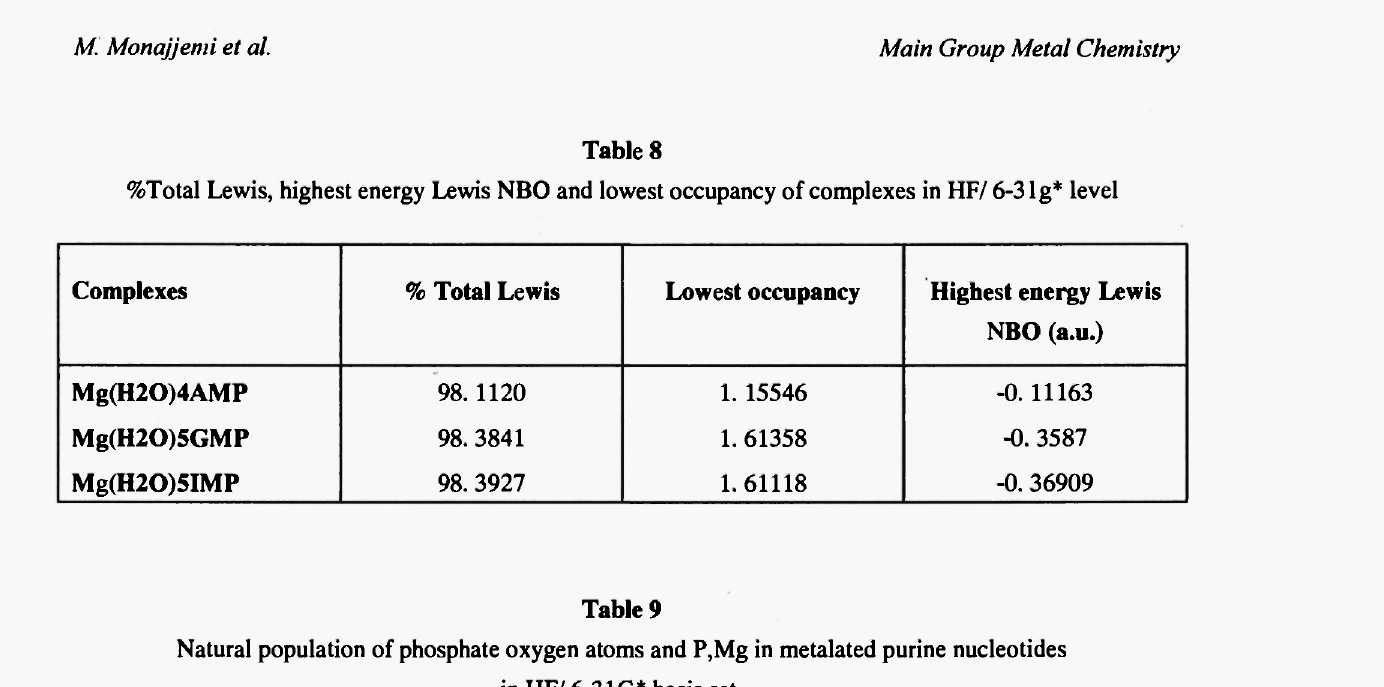
Natural population of phosphate oxygen atoms and P,Mg in metalated purine nucleotides in HF/ 6-31G* basis